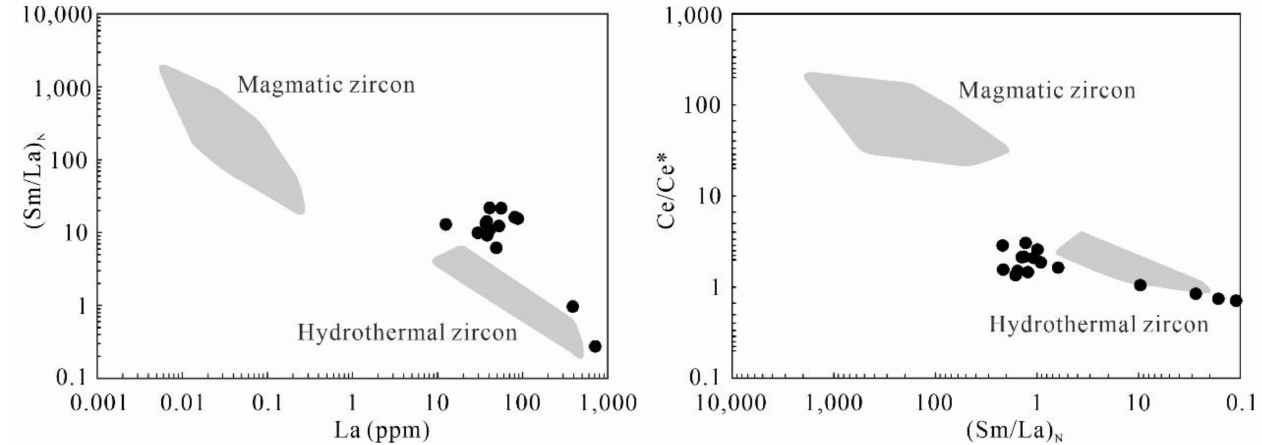
Figure 13. Discrimination diagrams of magmatic zircon and hydrothermal